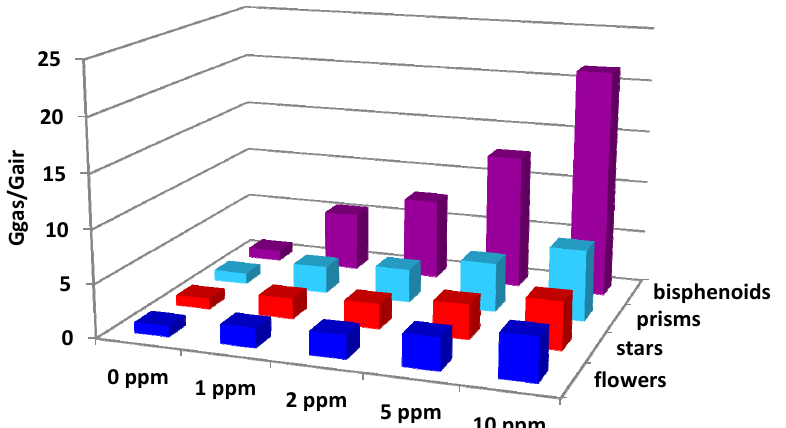
Figure 11. Responses to 10, 5, 2, and 1 ppm of formaldehyde at the operating temperature of 500 °C for flowers, stars, prisms and bisphenoids sensors.